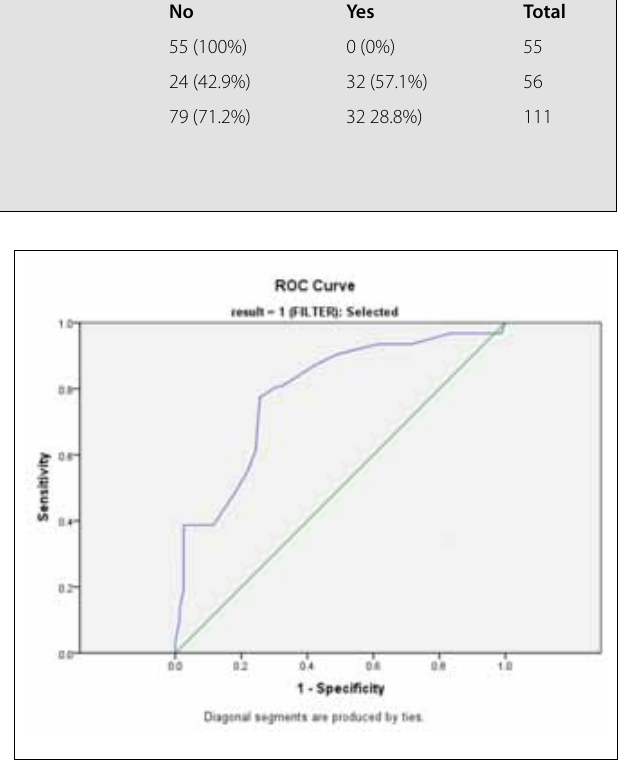
Fig 1. ROC curve of BDI scores v. suicidal ideation (BHS scores) in HIV-positive patients 72 hours after HIV diagnosis.